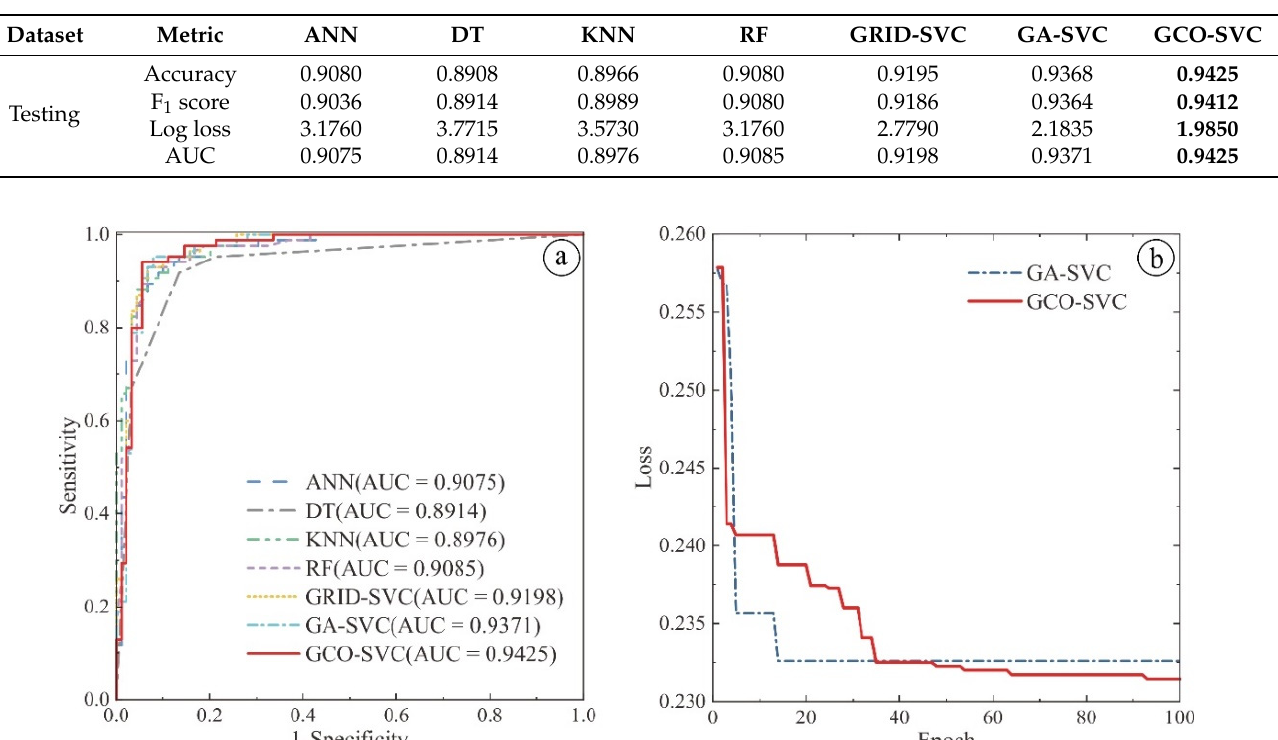
Table 6. Model performance on the training and testing sets.